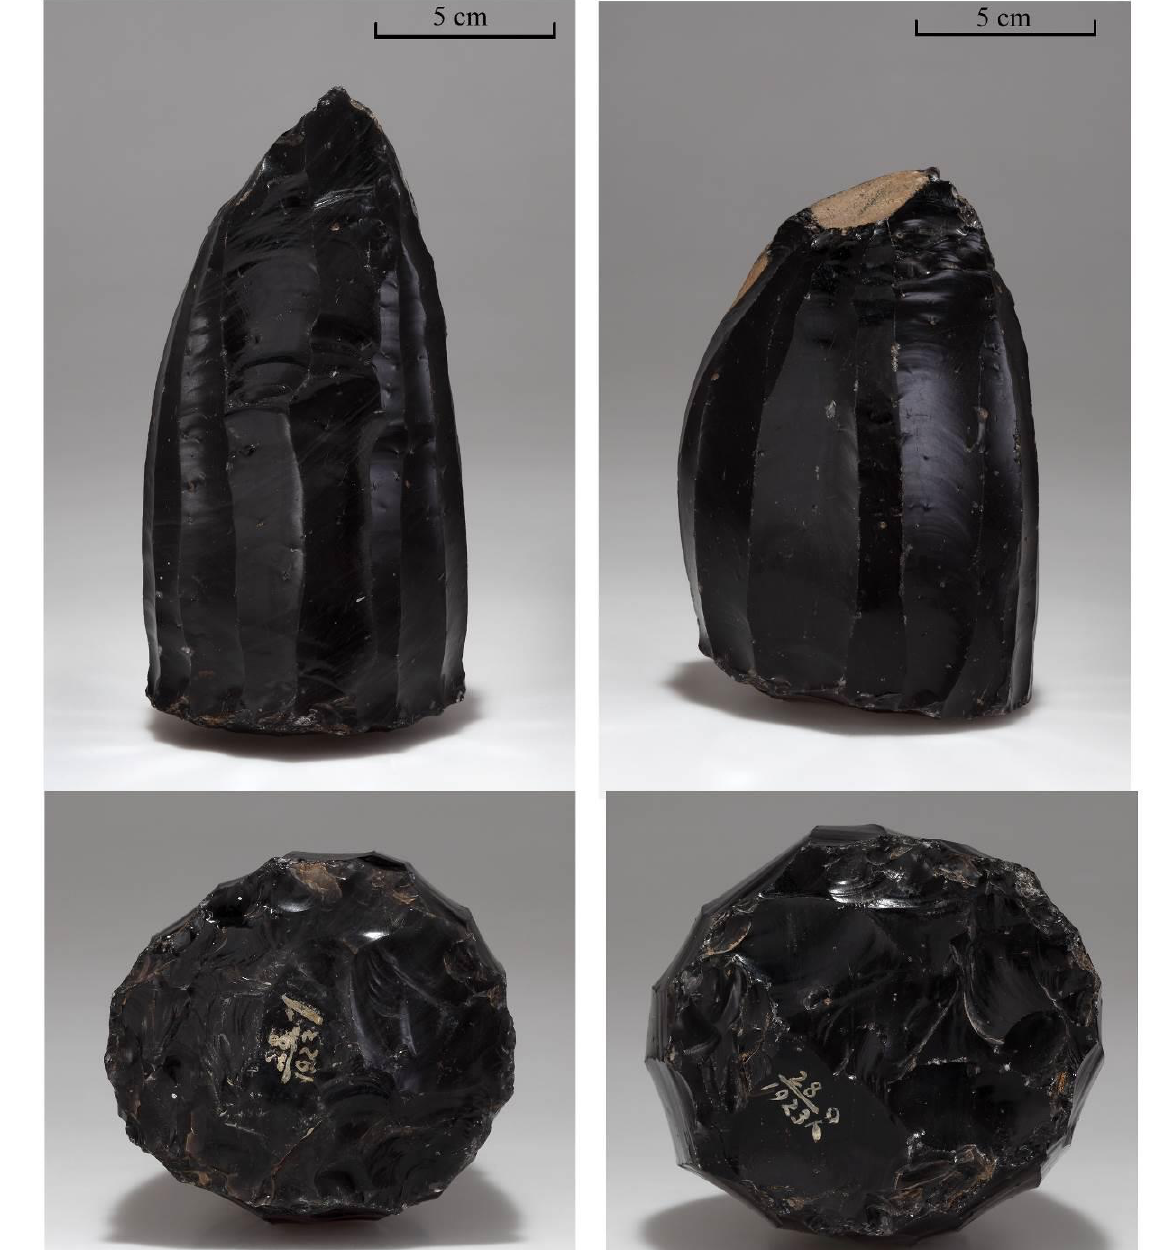
Figure 3. Typical conical blade cores from the Nyírlugos depot find (Inv. nr: HNM 1923.28.1-2). (Photo courtesy of Judit